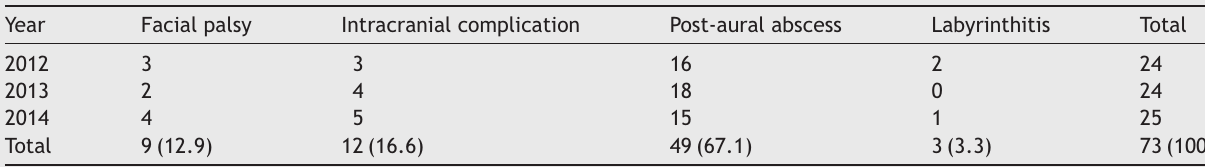
Percent values are in parenthesis.